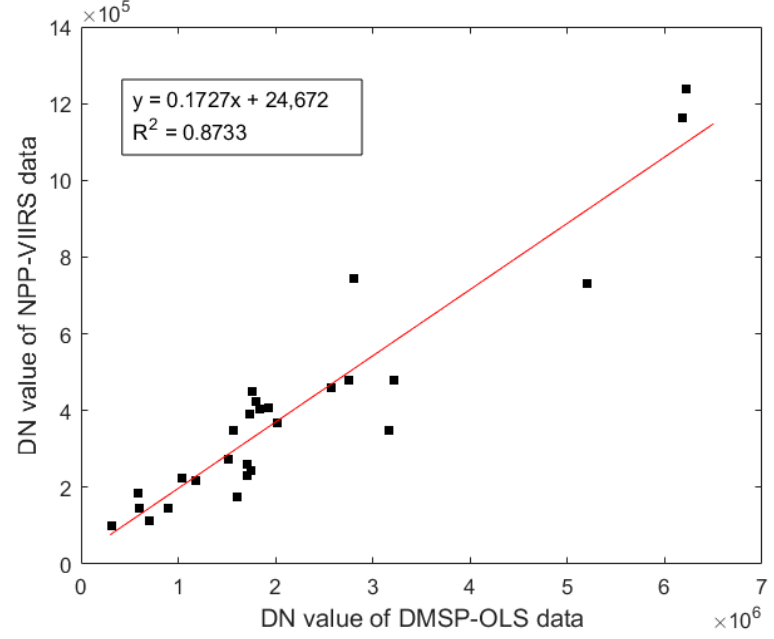
Figure 4. The fitting result of DMSP-OLS and NPP-VIIR. In Figure 4, the dots represent Chinese provinces. Tibet, Hong Kong, Macao, and Taiwan were excluded from the study due to the lack of complete information. The abscissa is DMSP data and the ordinate is VIIRS data. It can be seen from the figure that DMSP, in 2013, has a good linear correlation with VIIRS data, and the fitting degree can reach 0.8733 by using the linear model, indicating that this regression model is highly representative. Therefore, a regression equation was obtained to integrate DMSP-OLS data with NPP-VIIRS data. The formula is shown in Equation